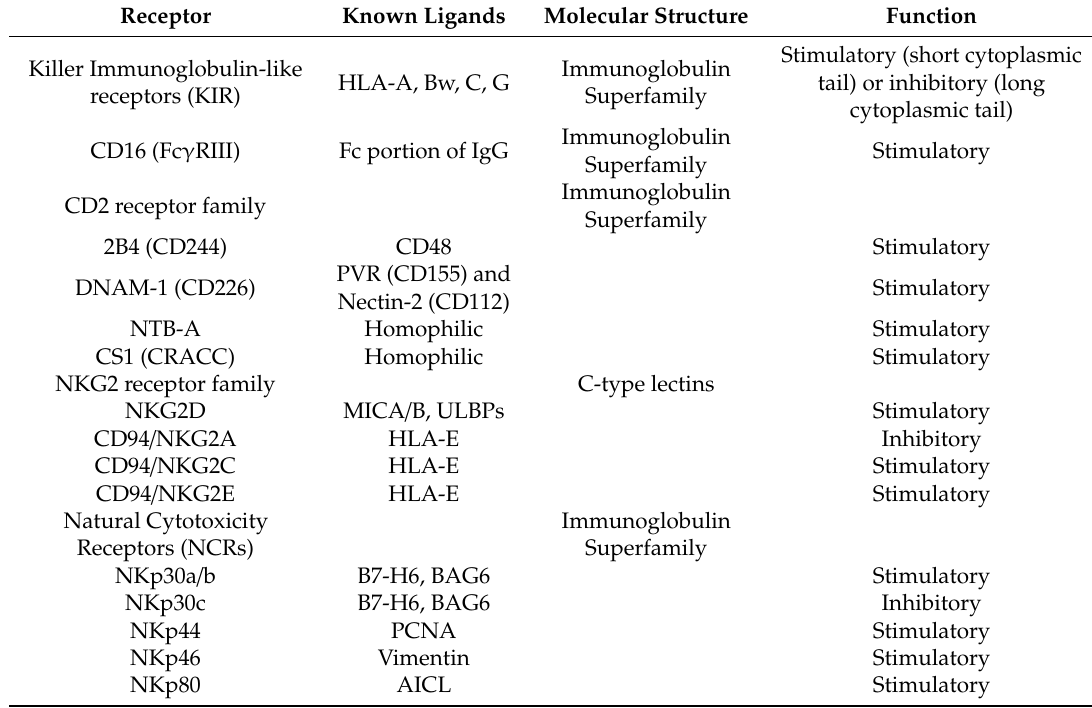
Table 1. A brief summary of natural killer (NK) cell activating and inhibitory